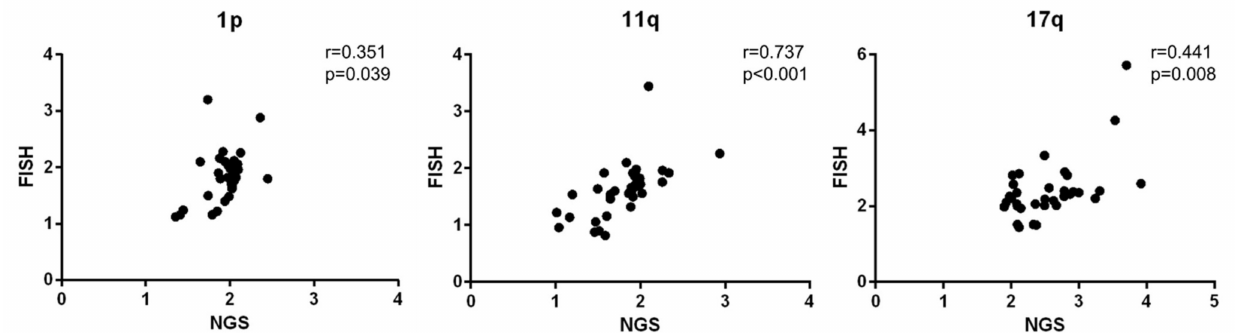
Figure 3. Copy numbers of 1p, 11q, and 17q were statistically correlated between NGS and FISH.